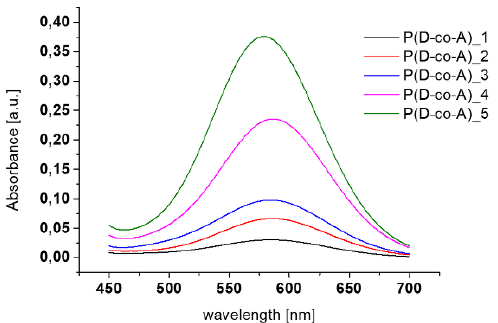
Figure 2. Absorbance of P(D-co-A) copolymers before modifications. 267